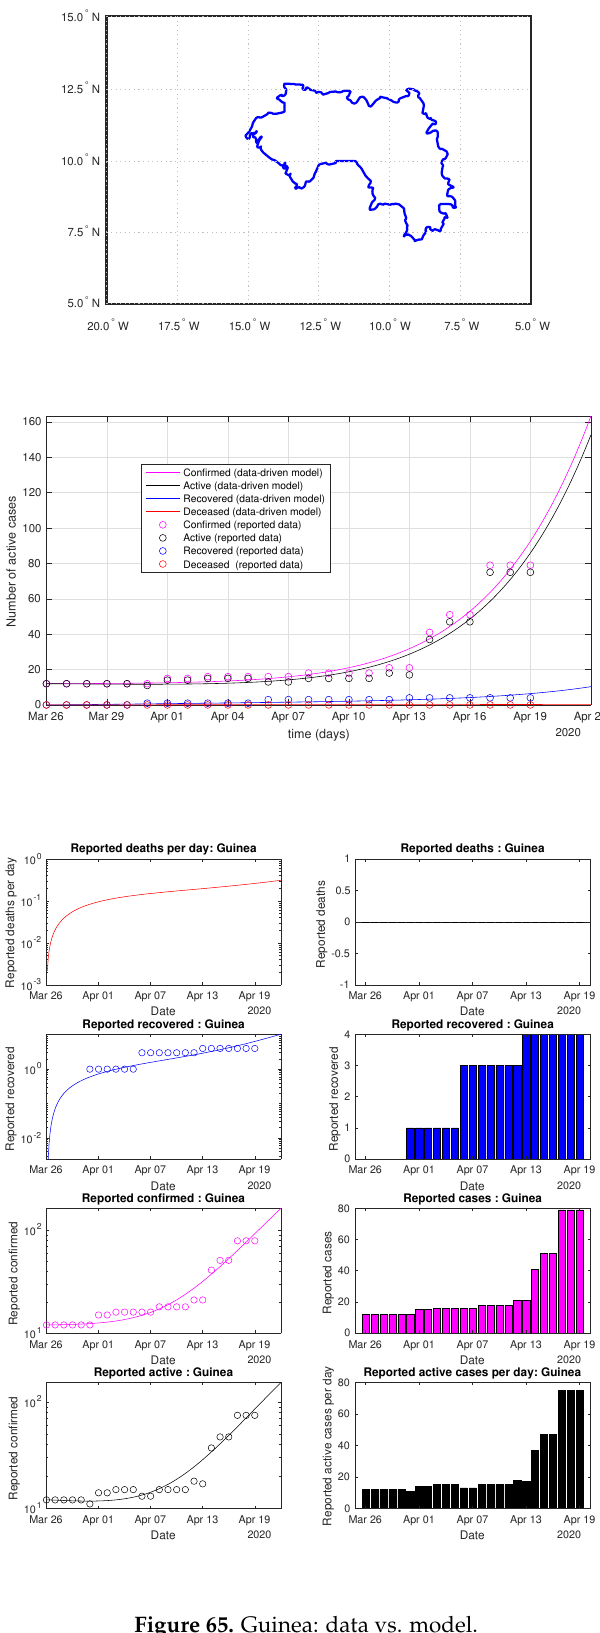
Figure 65. Guinea: data vs.